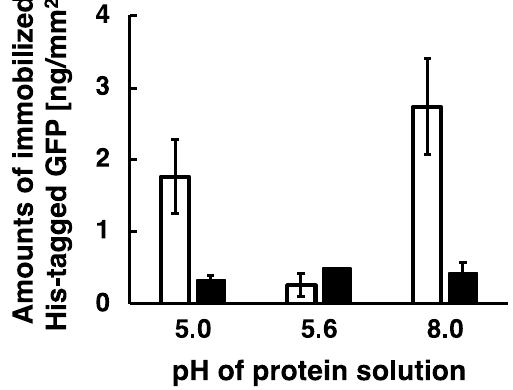
Figure 6. Histogram of amounts of immobilized His-tagged GFP at a pH 5.0, 5.6, and 8.0. To prevent an aggregation of His-tagged GFP due to the acidic condition, this experiment shortened the duration time of the application of AC electric field. The conditions of applying AC electric field are described as follows: 20 Hz at the constant applied voltage of 80 Vpp for the duration time of 10 min. White bars and black bars indicate the amounts of His-tagged GFP immobilized on the substrate surfaces after wash buffer and imidazole treatment, respectively. Error bars represent the standard deviations from three independent experiments.